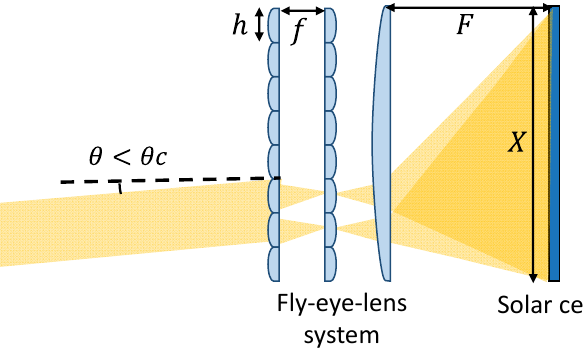
Figure 1. Schematic operation principle of the fly-eye lens system. For an elemental lens height h , elemental lens focal length f , and imaging lens focal length F , the irradiation beam height H is calculated by Equation